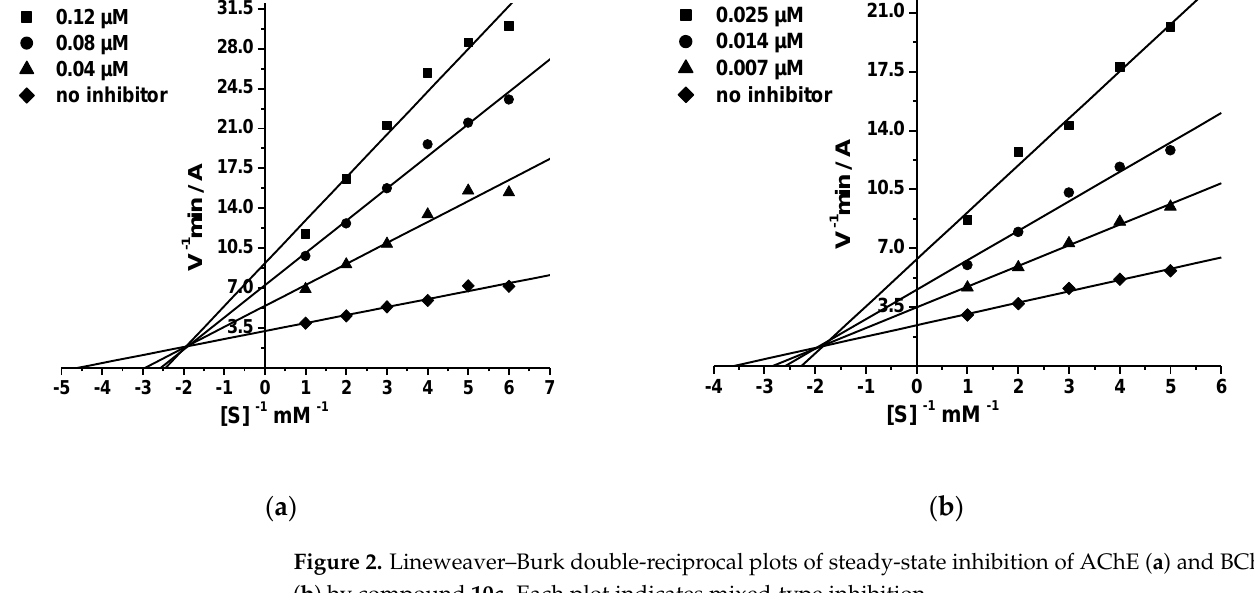
Figure 2. Lineweaver – Burk double-reciprocal plots of steady-state inhibition of AChE ( a ) and BChE ( b ) by compound 10c . Each plot indicates mixed-type inhibition. Table 2. Inhibition constants of cholinesterases by conjugates 5c – 8c , 10c 1 . AChE Compound